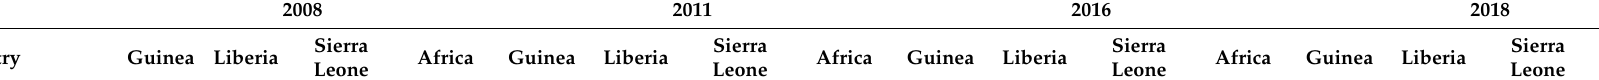
Table 5. ODA quality